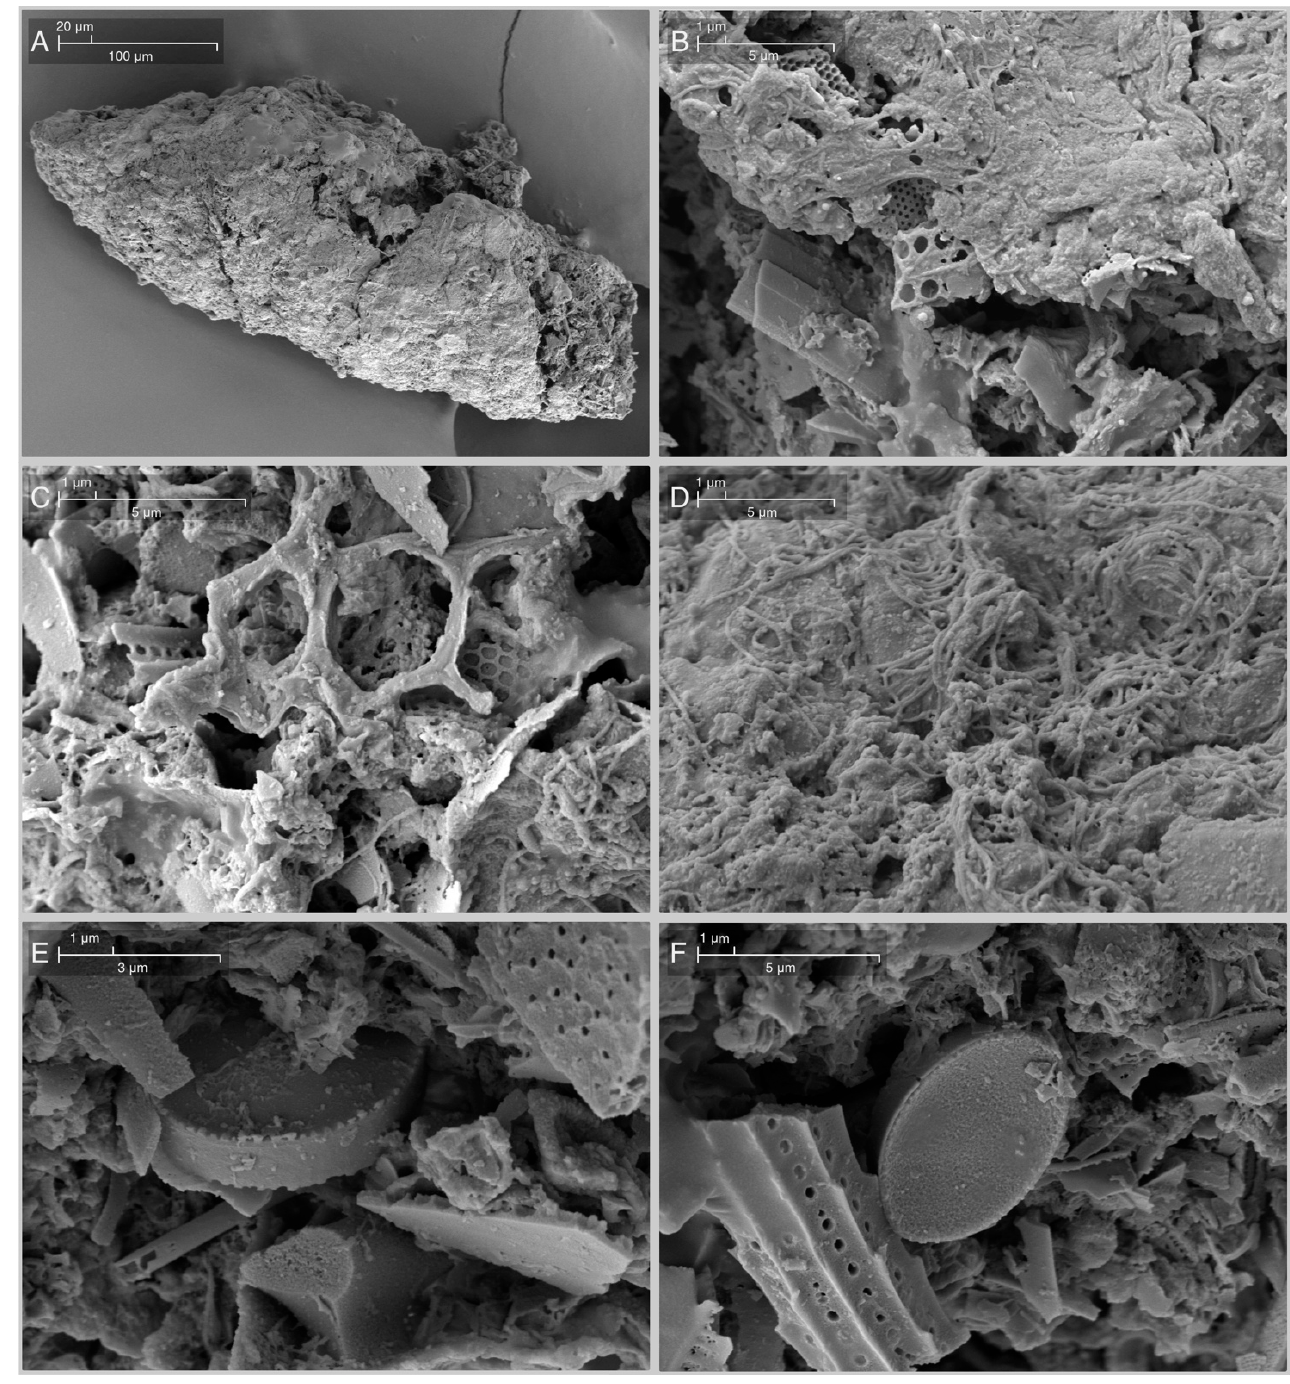
Figure 4. Pellets of paratype of Provanna annae sp. nov. (Same specimen as Figure 3E,F.). ( A ) General view of pellet; ( B – F ) Details of food facilities.